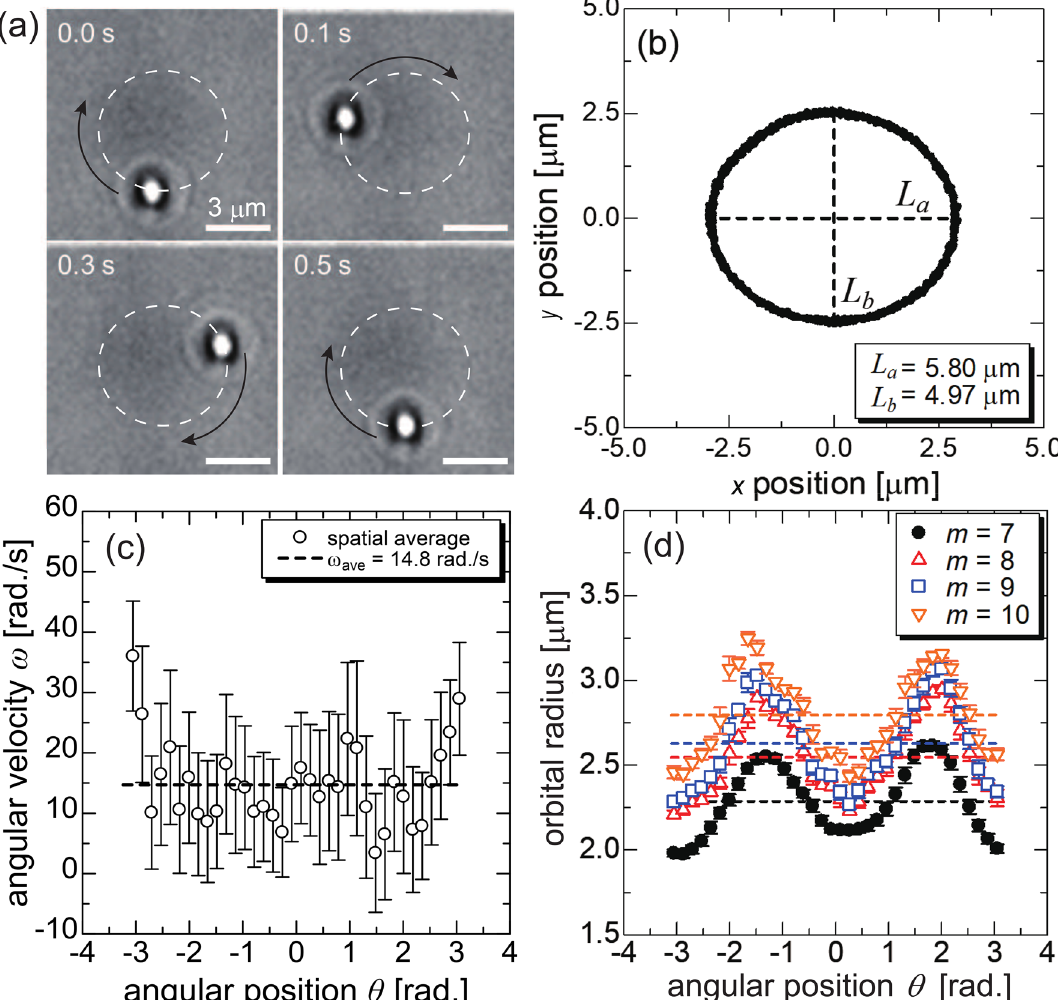
Figure 2. Orbital motion of single PS particle with a diameter of 1 µ m driven by the LG beam with a 8 in a channel without orifices. ( a ) Snapshots of the orbital motion. The white dashed topological charge m = ellipse represents the trajectory of the orbital motion. The scale bars denote 3 µ m. ( b ) Trajectory of the orbital motion acquired by the particle tracking analysis. L a and L b denote the lengths of the major and minor axes, respectively. ( c ) Dependence of angular velocity on the angular position. Spatial average and error bars denote the average value and its standard deviation among each 0.1 π rad, respectively. The ω ave in ( c ) represents the average among all values. ( d ) Profiles of the ellipsoidal orbit driven by the LG beams with various values of m between 7 and 10. Each plot and corresponding error bar denote the spatial average and standard deviation of the particle